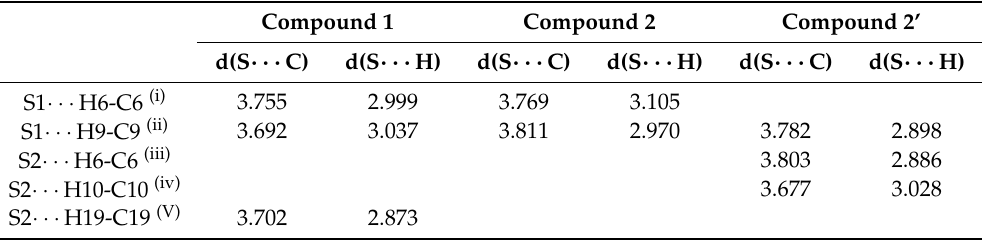
Table 2. Intermolecular S ⋯ H (Å) and corresponding S ⋯ C (Å) distances for compounds 1 , 2 , and 2’.